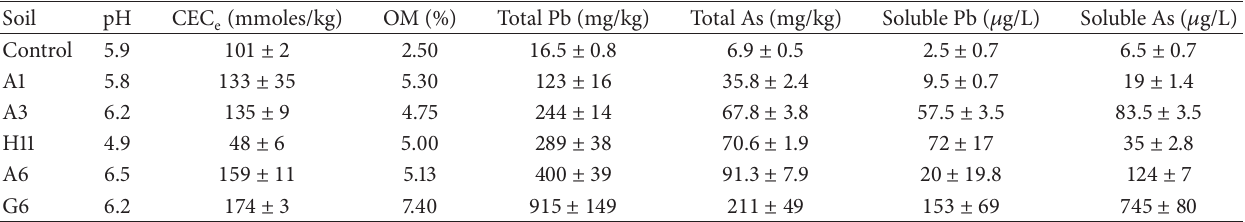
Table 1: Important properties and total and water-soluble Pb and As of the orchard soils. Standard deviations of mean values based on and total and soluble Pb and duplicate measurements are reported for CEC e